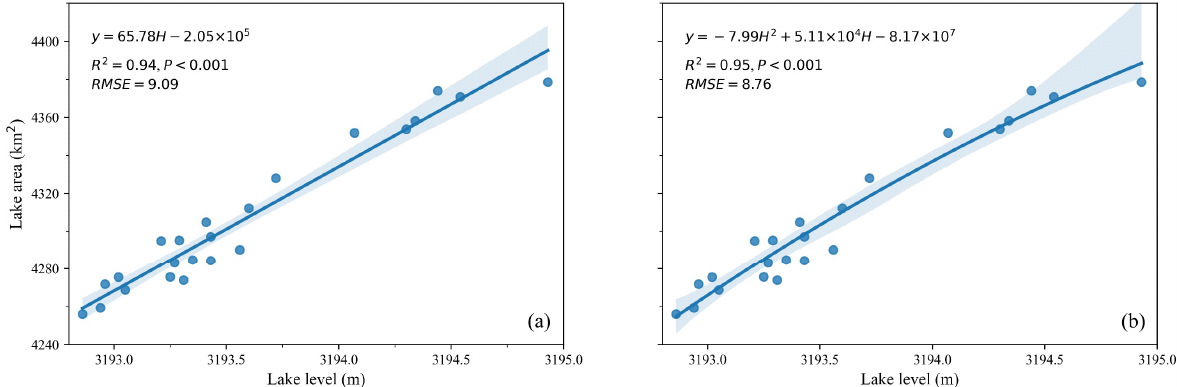
Figure 3. Relationship between the lake area and the measured lake level, ( a ) unary linear model and ( b ) quadratic polynomial model. The abscissa represents the elevation of lake level, and the ordinate represents lake area, shaded area represents the 95% confidence intervals.